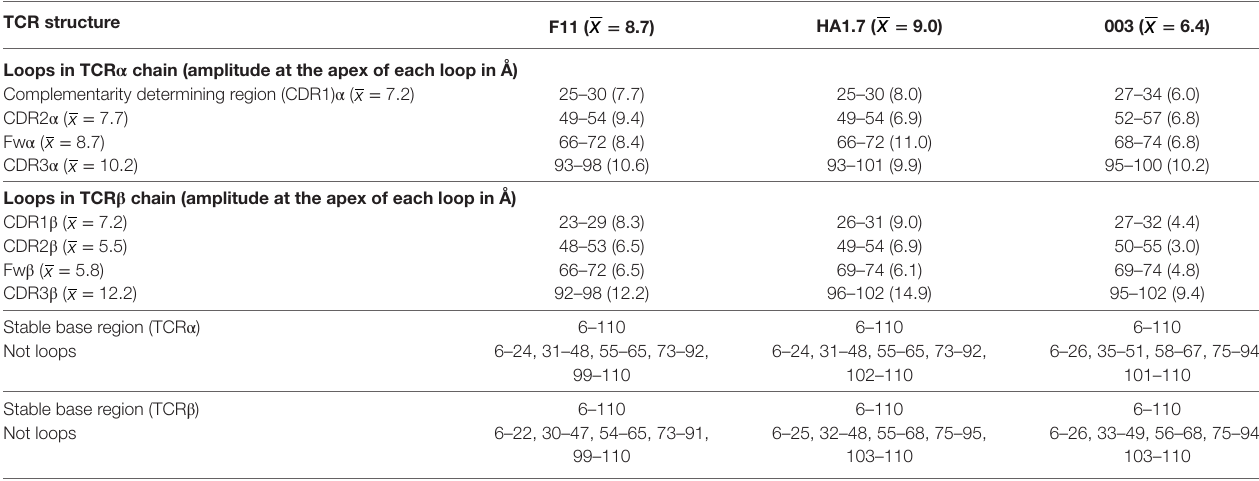
Table 5 | Domain and loop identification in T cell receptor (TCRs). Tcr structure